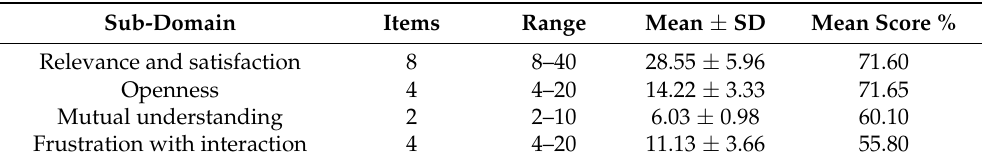
Table 3. Subscale scores of nurses’ perceptions of quality of nurse–physician communications in emergency departments.